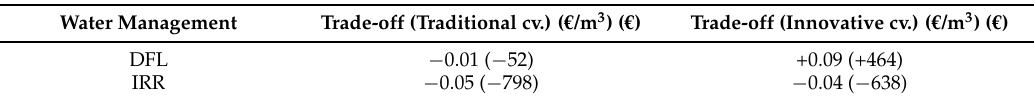
Table 3. Trade-offs between conflicting objectives per alternative water management and typology of rice variety.